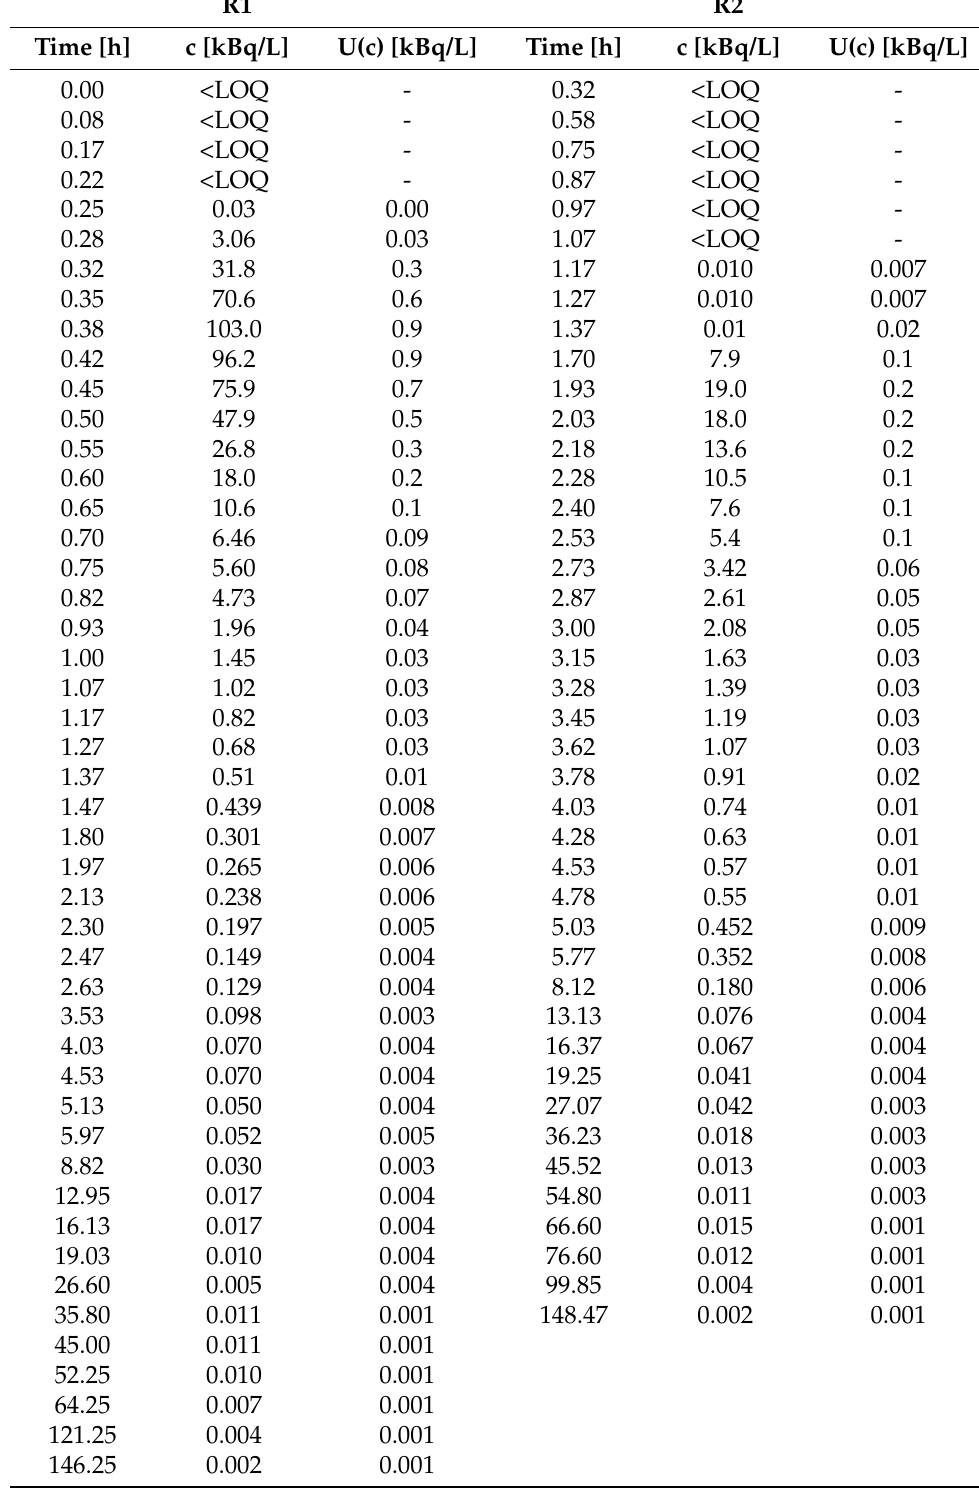
Table A5. In-stream 32 P activity concentrations and their analytical uncertainties at points R1 and